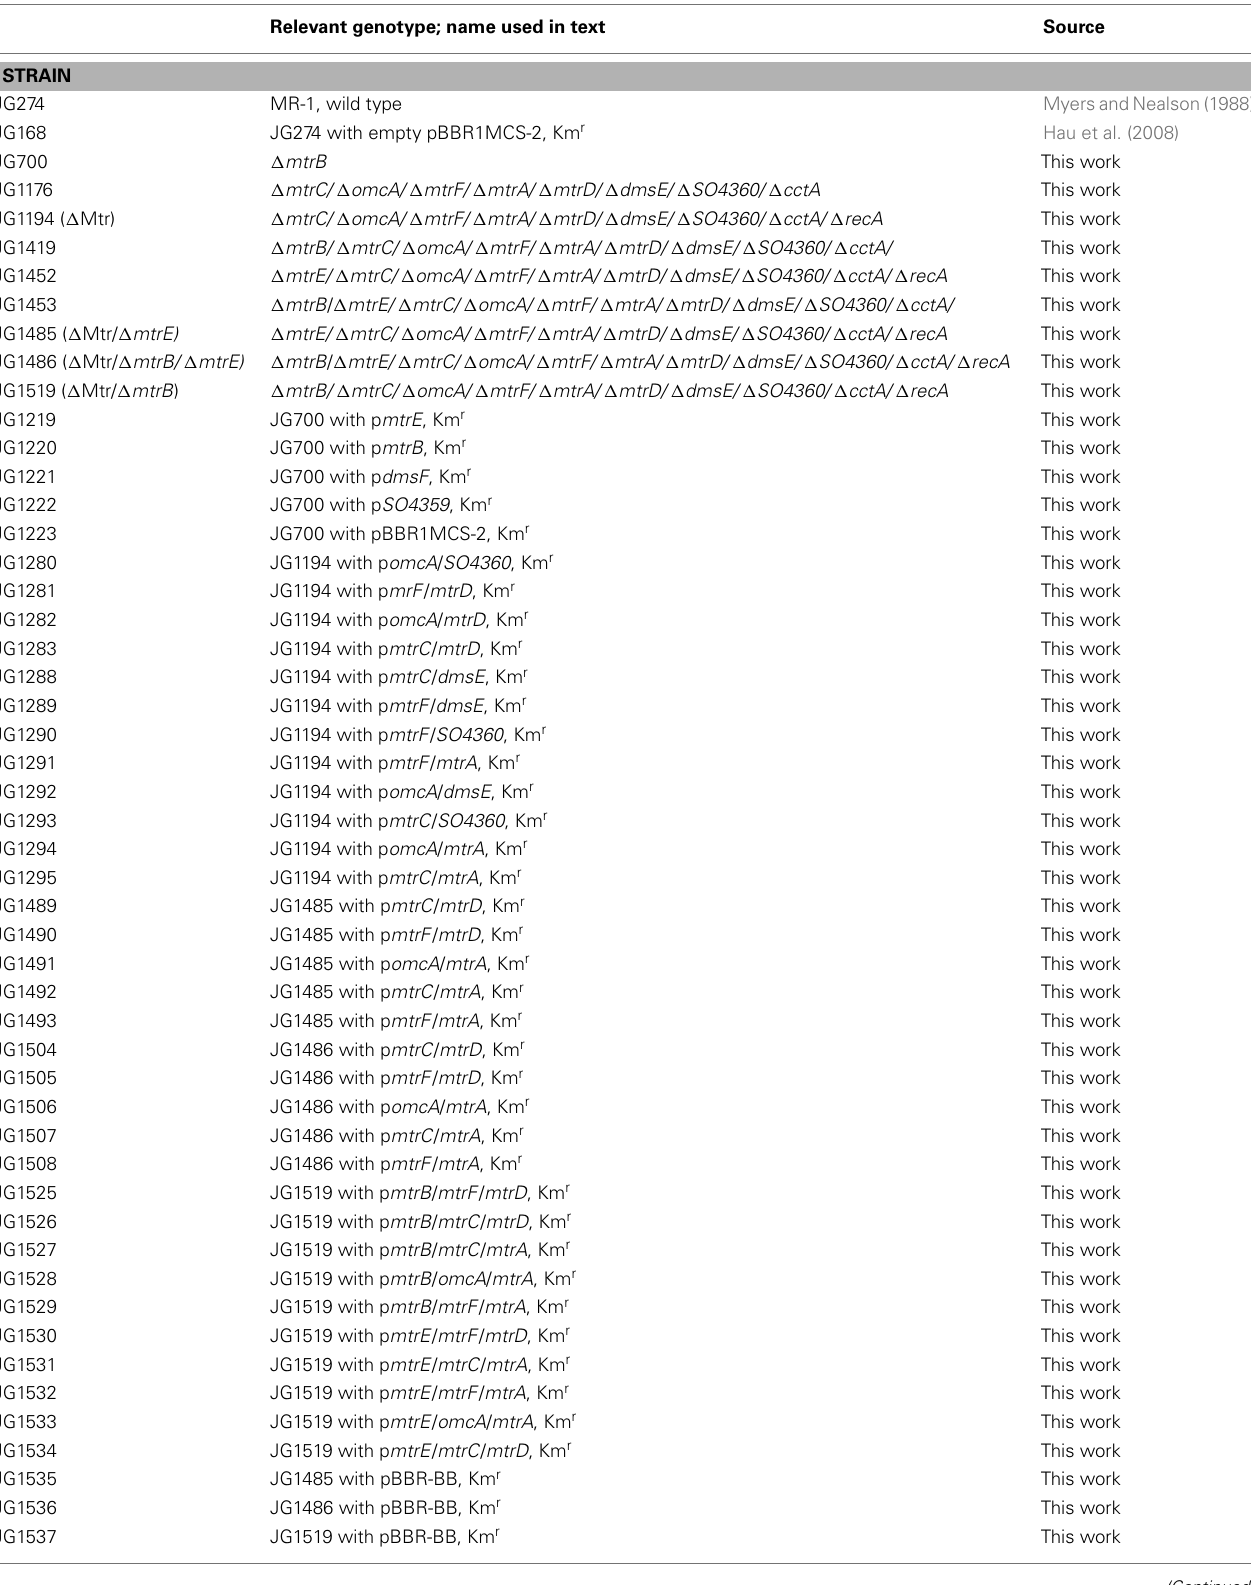
Table 2 | Strains used in this